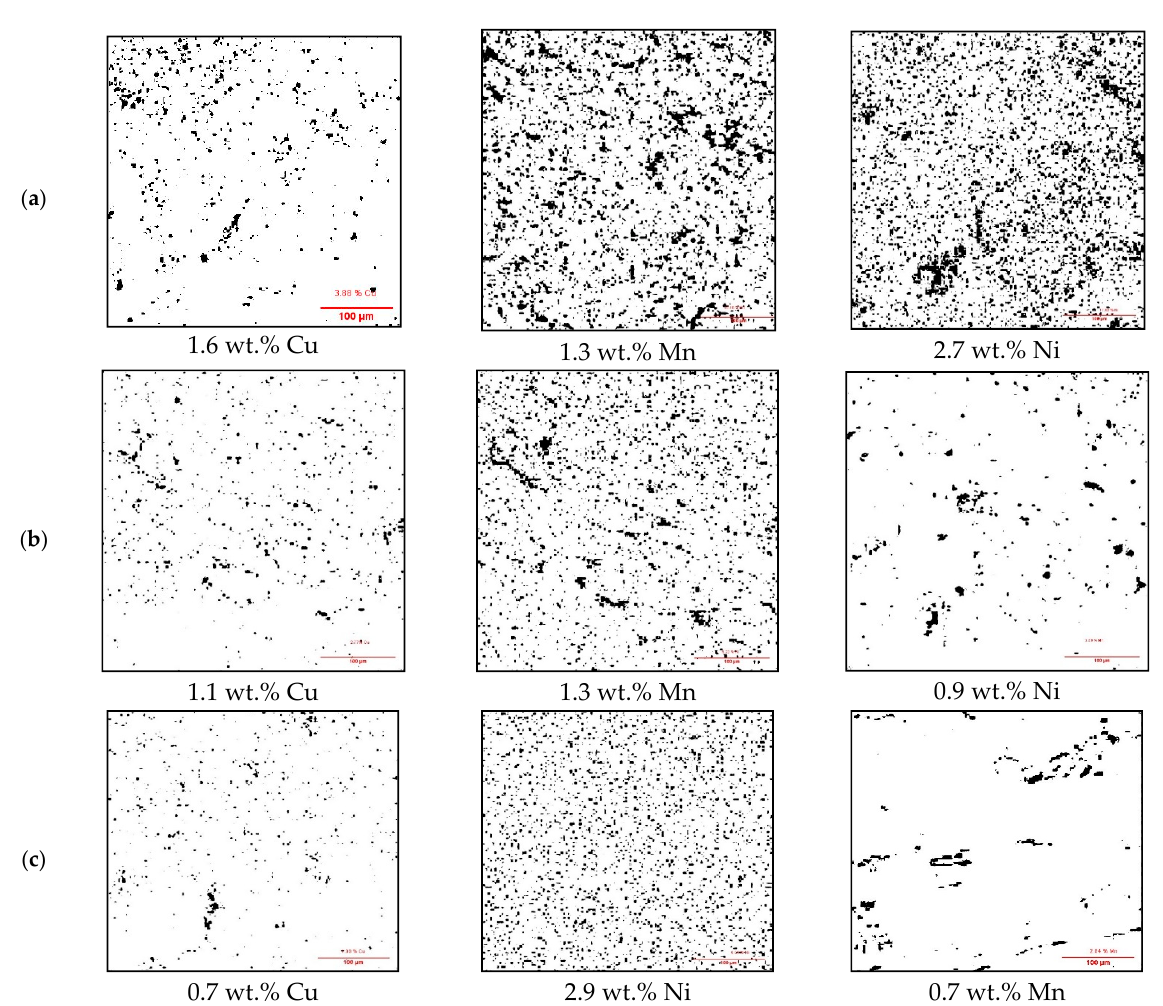
Figure 8. Elemental mapping for ( a ) As-received Al CC from used batteries, ( b ) Al CC from recycled batteries after melting, and ( c ) Al CC from recycled batteries after reuse in new battery and